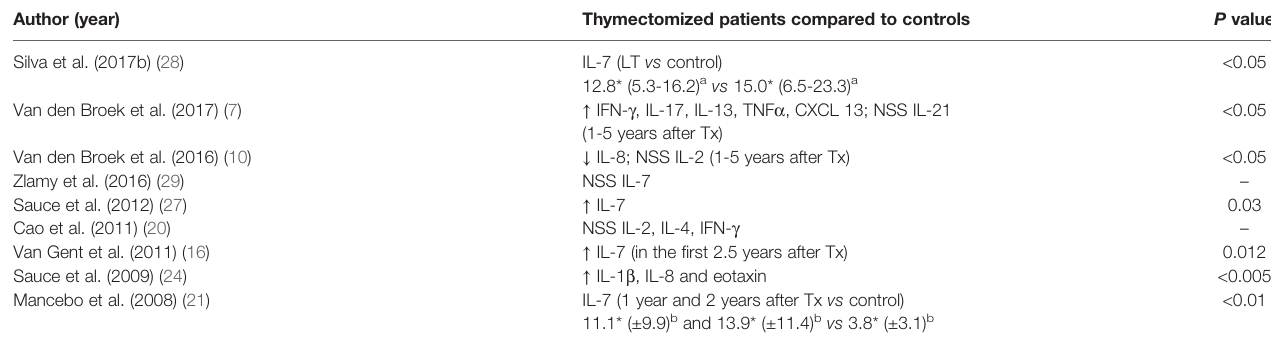
TABLE 8 | Main results regarding levels of cytokines of included studies.